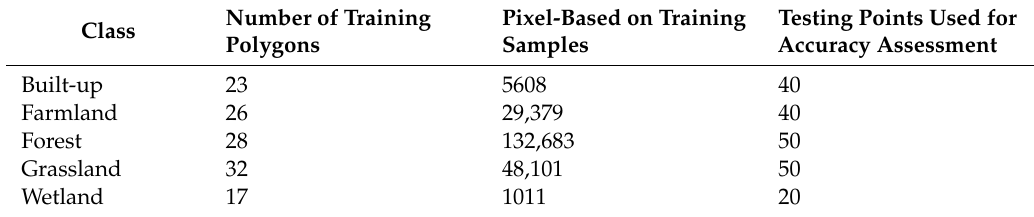
Table 2. Training polygons, samples, and testing points for 2003.